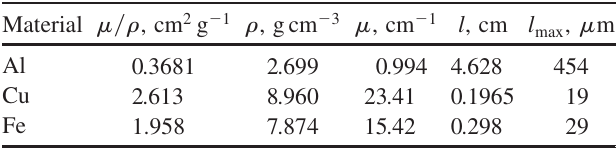
TABLE IX. Attenuation coefficients, densities, and penetra-